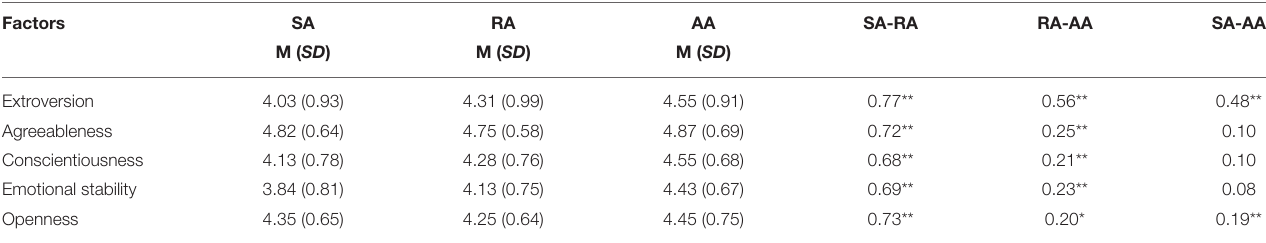
TABLE 1 | The descriptive statistics and correlations between three types of appraisals.